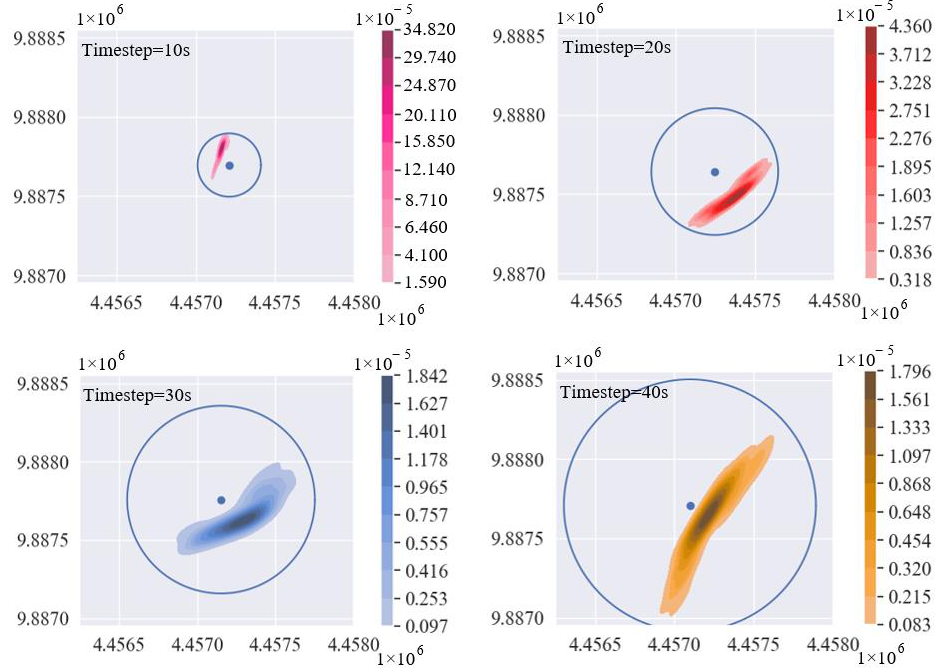
Figure 5. Illustration of the position distribution for the drone.